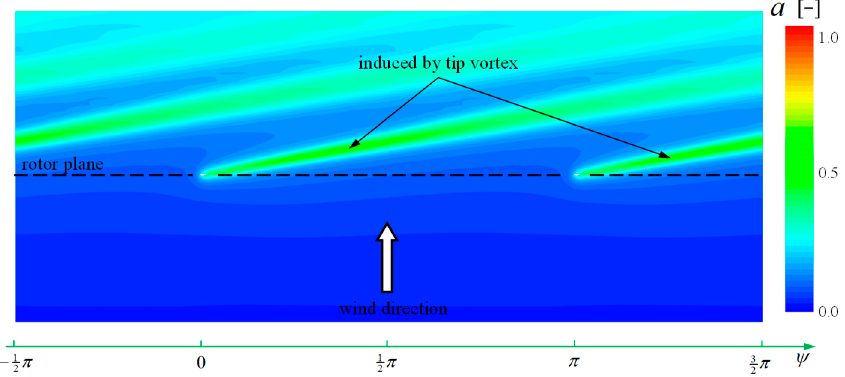
section of r / R = 95% ( 7m/s V ∞ = ). Figure 10. Contours of axial interference factor after the self-induction subtraction in the flatten section